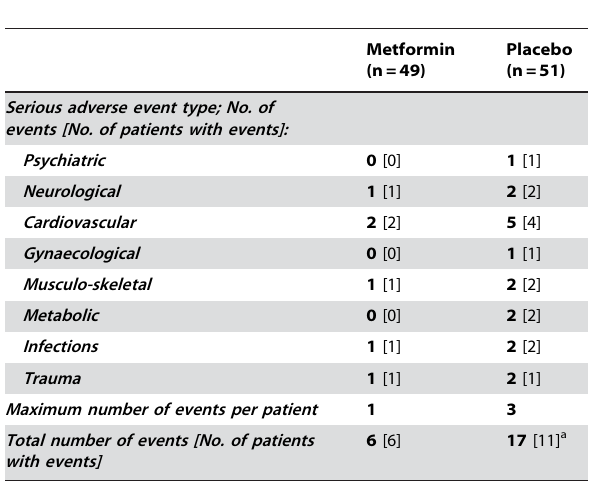
Table 5. Non-hypoglycaemia-related serious adverse events in 100 patients with type-1 diabetes allocated treatment with metformin or placebo for one